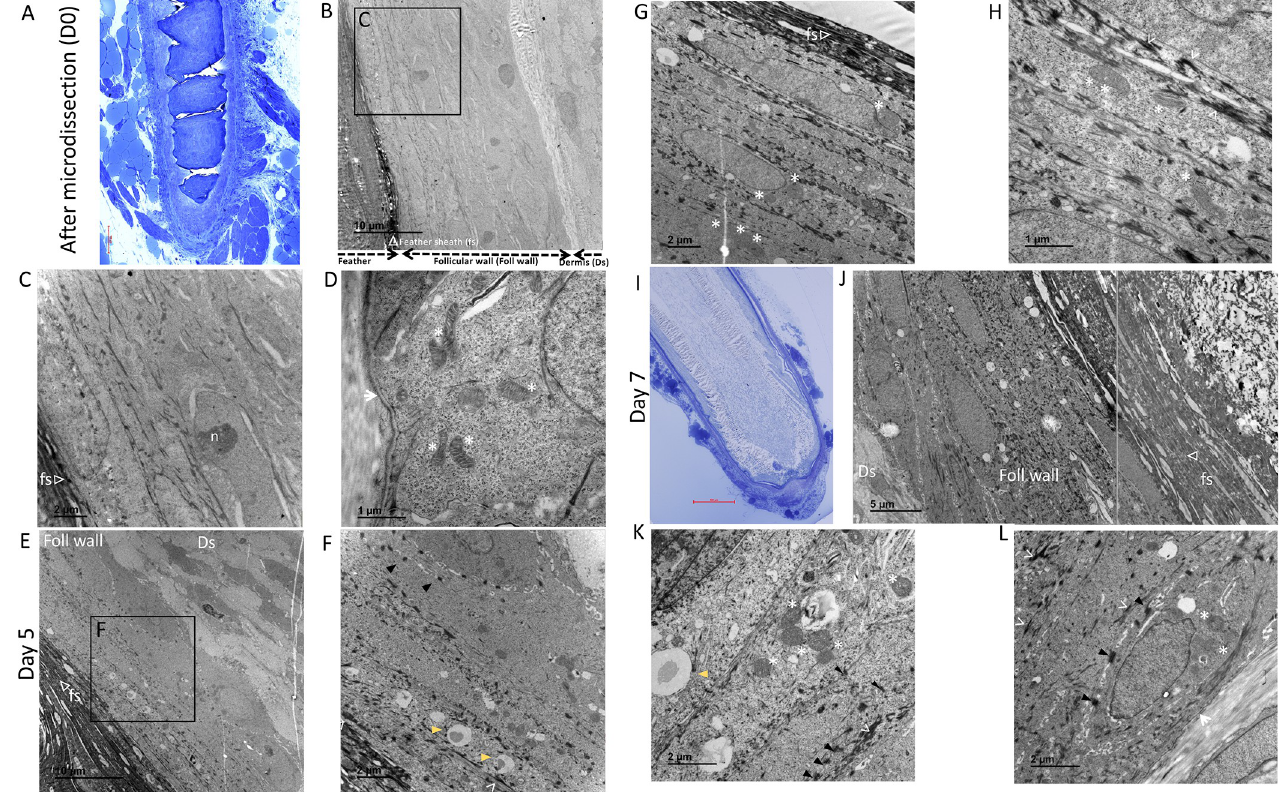
Fig 5. Morphology of the FF by TEM. Images of semi-thin section of a FF after microdissection (Day 0) (A) and at Day 7 (I), stained with toluidine blue observed by optical microscopy are shown and correspond to the level of the ultra-thin sections observed at these time points. Images of FF observed by TEM at different magnifications at Day 0 (B-D), Day 5 (E-H), Day 7 (J-L). Note that J was generated by merging two pictures. Regions enlarged in another picture are indicated with black frames. On panel (B), the dermis (Ds) and the follicular wall (foll wall) are indicated as well as part of the feather. A few structures are shown on the images: feather sheath (fs; empty white triangle), basal membrane (white short arrow), mitochondria (white asterisk symbol), nucleolus (n), keratin bundles (white plain arrowhead), desmosome (black plain triangle), lipid droplet (yellow plain triangle).